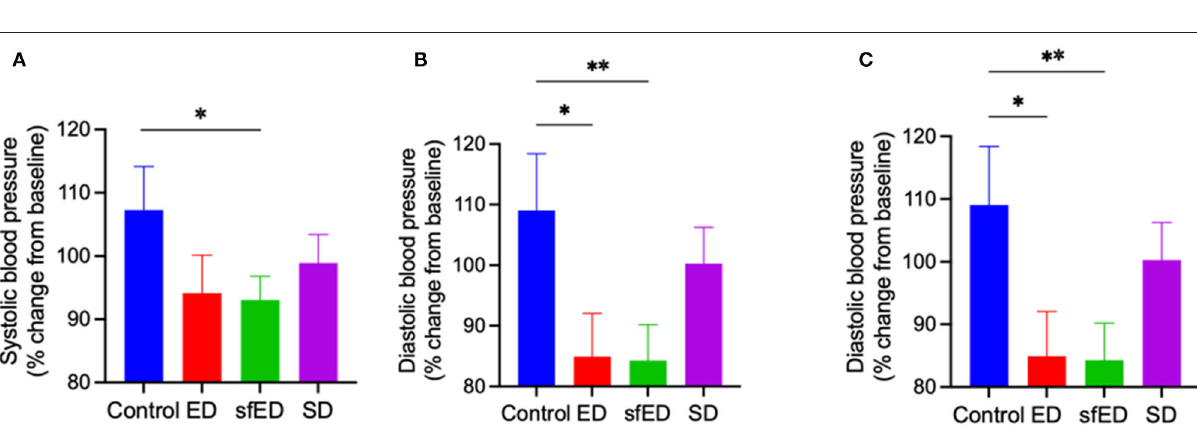
FIGURE 3 | Blood pressure. The mice received Mother (ED), sugar-free Mother (sfED), Coca-Cola (SD), or water (Control) for 13 weeks. The change in systolic blood pressure (A) , diastolic blood pressure (B) , and mean arterial pressure (C) between baseline and at the end of the experiment (13 weeks) were measured using a tail cuff method. Statistical analysis was performed using a one-way ANOVA with Fisher’s LSD post-hoc analysis ( n = 10; * p < 0.05, ** p <